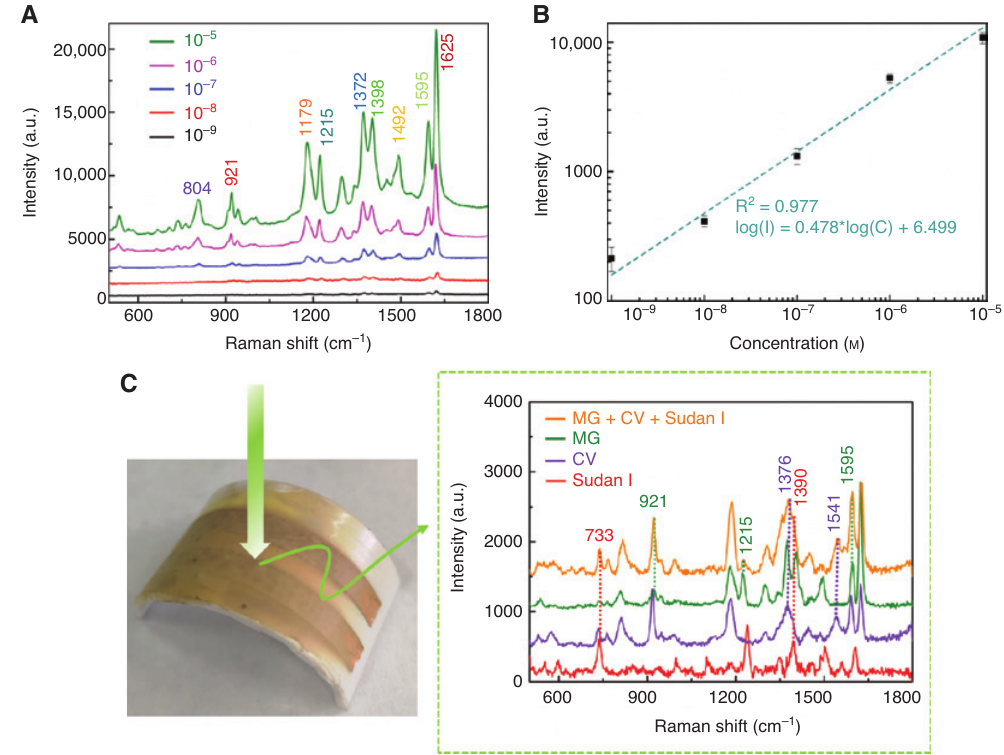
Figure 7: Practical application of the designed SERS substrate onto arbitrary surface. (A) The Raman spectra of MG (concentration from 10 −5 to 10 −9 m) on the AgNPs/PVA@Ag nanofibers substrate. (B) Raman intensity of MG (at 1618 cm −1 ) on the substrate as a function of the molecule concentration. (C) SERS spectra of Sudan red I (10 −6 m, red line), CV (10 −9 m, purple line), MG (10 −7 m, green line) and their mixtures (orange line) detected on the in-situ electrospinning AgNPs/PVA@Ag nanofibers